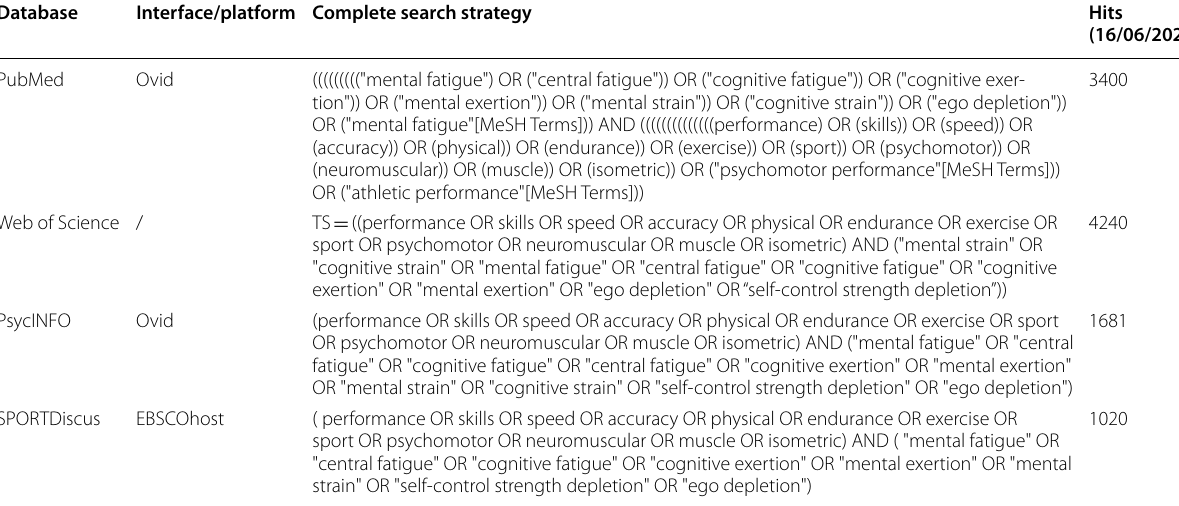
Table 1 Search strategies and number of hits for the PubMed (MEDLINE), Web of Science, PsycINFO and SPORTDiscus databases